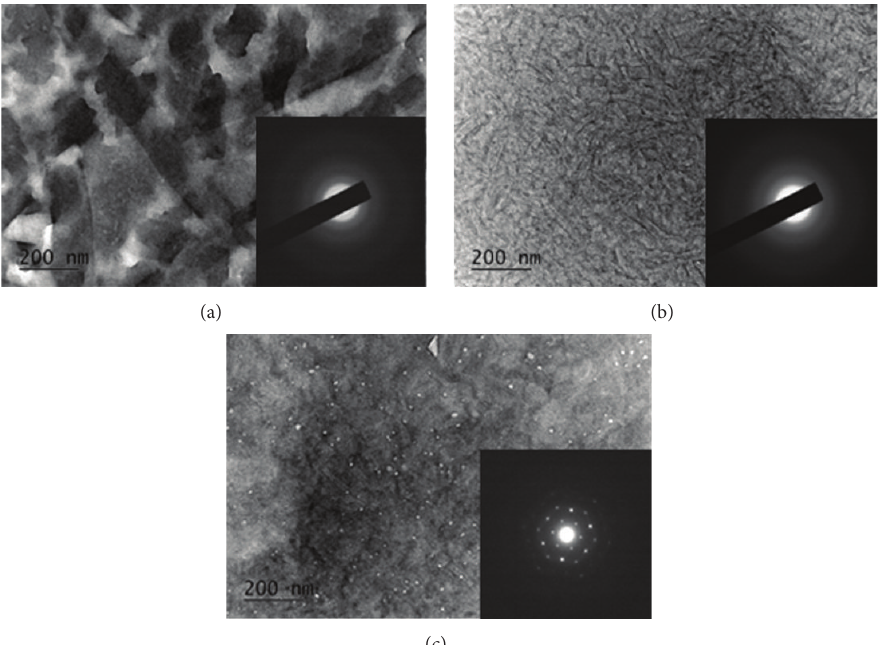
Figure7:TEMimagesandcorrespondingSAEDpatternsasinsetsoftheas-cast(a),bestperforming-SVTwithTHFfor4 s(b),anddegraded- SVT with THF for 80s